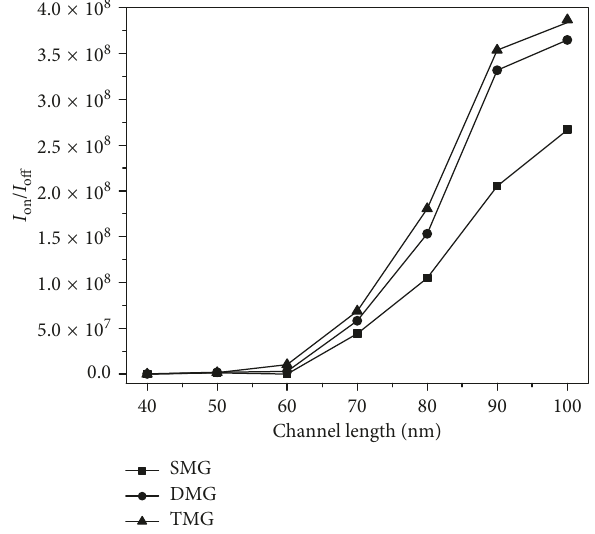
Figure 9: I on / I off at various channel lengths for SMG, DMG, and TMG Re-S/D SOI MOSFET.